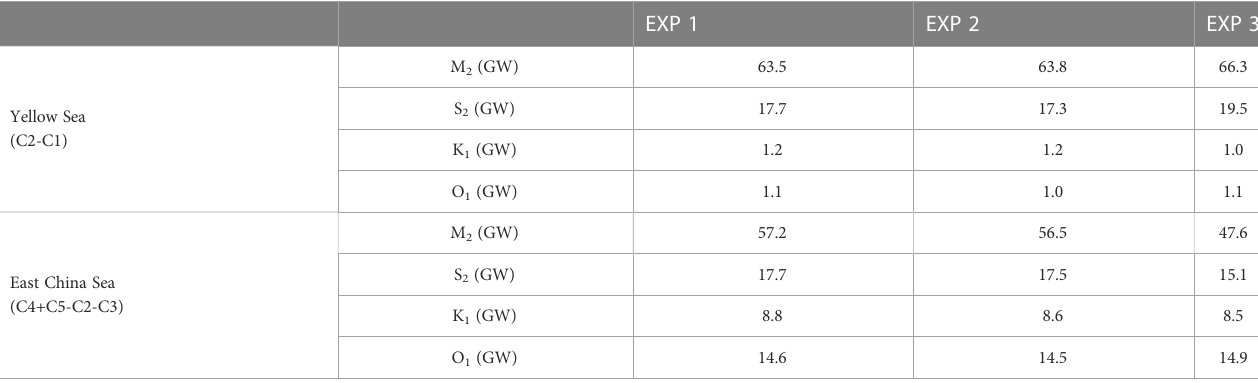
TABLE 3 The total tidal dissipation in the Yellow and East China Seas.